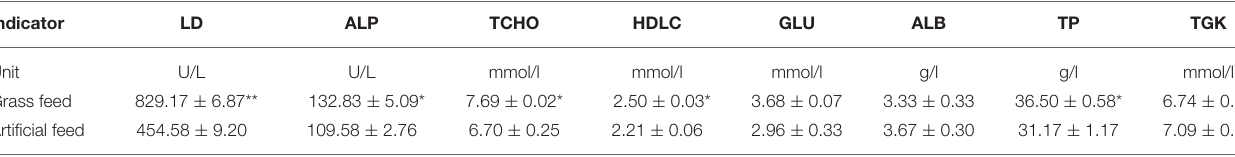
TABLE 3 | Serum biochemical parameters in C. idellus cultured under two feeding models. Indicator